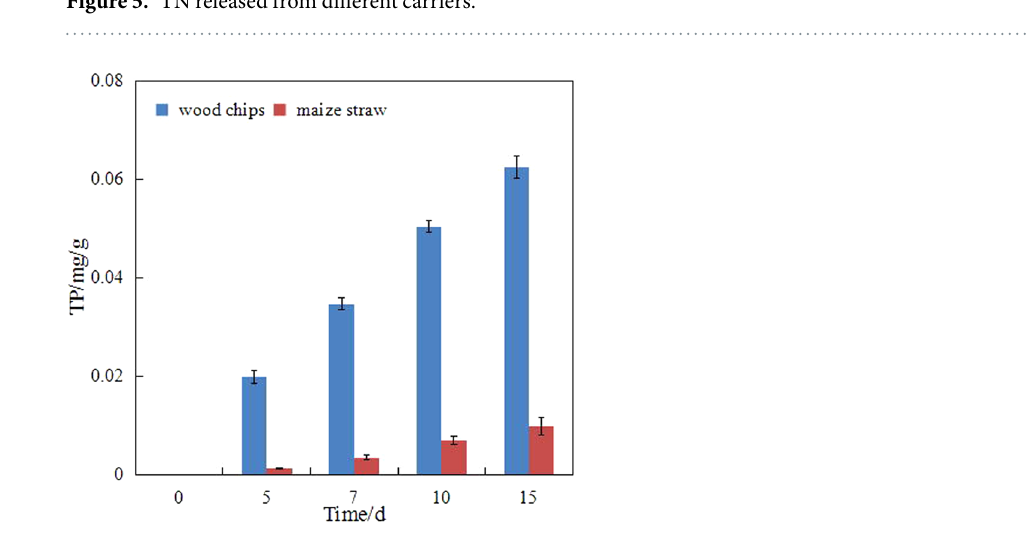
Figure 6. TP released from different